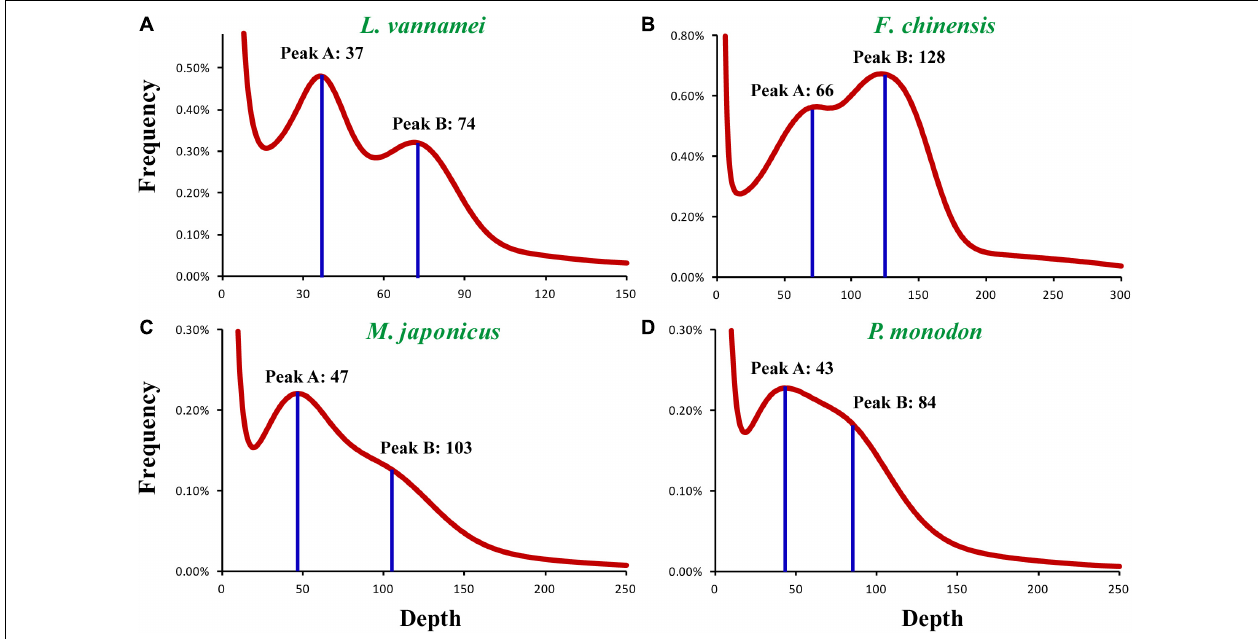
FIGURE 1 | K-mer distribution of four penaeid shrimp genomes. The K-mer distribution plots of the four shrimp species include (A) L. vannamei , (B) F. chinensis , (C) M. japonicus , and (D) P. monodon . K = 19 was selected for the K-mer frequency statistics.